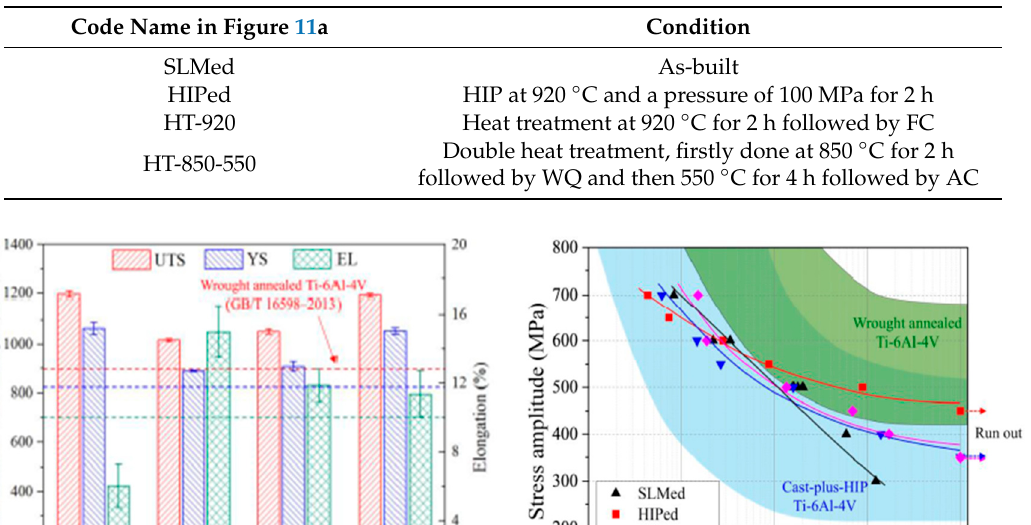
Table 2. Distinct heat treatments performed by Yu et al. [73]. FC: furnace cooling, WQ: water quenching.